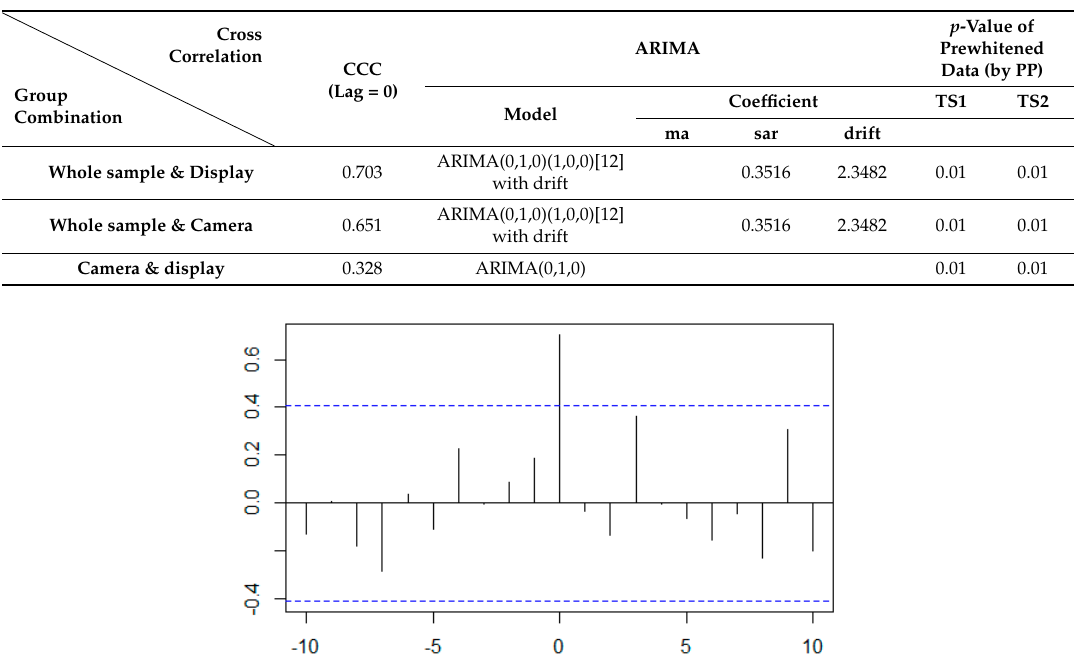
Figure 5. Average CAR for evaluation period: the month in which each company was listed-2008, Event period: 2010–2012. Table 3. Cross-correlation of average CARs for Evaluation period: the month in which each company was listed-2008, Event period: 2010–2012.